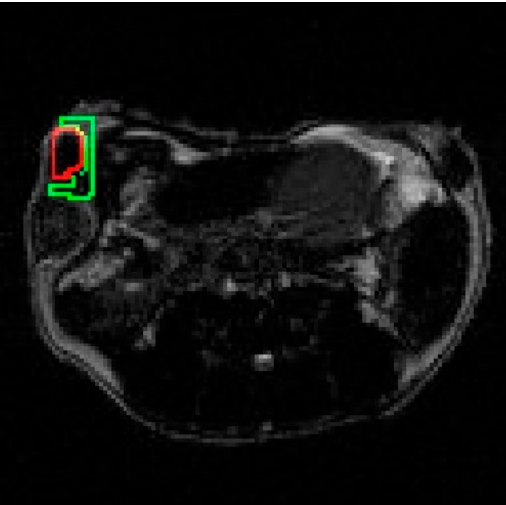
Figure 2. Selection of the ROIs in the mouse abdomen MRI: green line delineates the adjacent tissue, and the red line delineates the tumor.